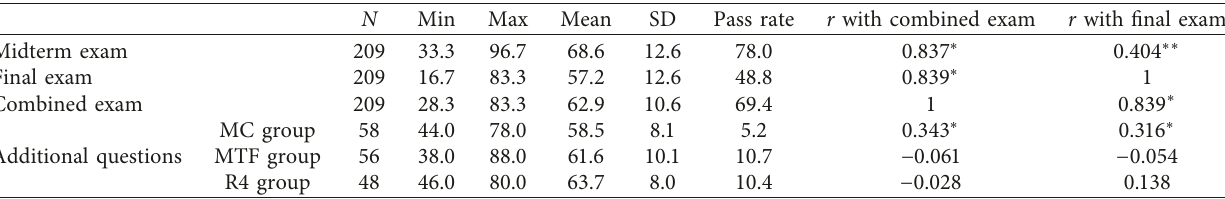
Table 4: Summary of performance in the 2013 regular exams and additional questions. The values given (except N and the correlations) are the respective percentage of the maximum possible